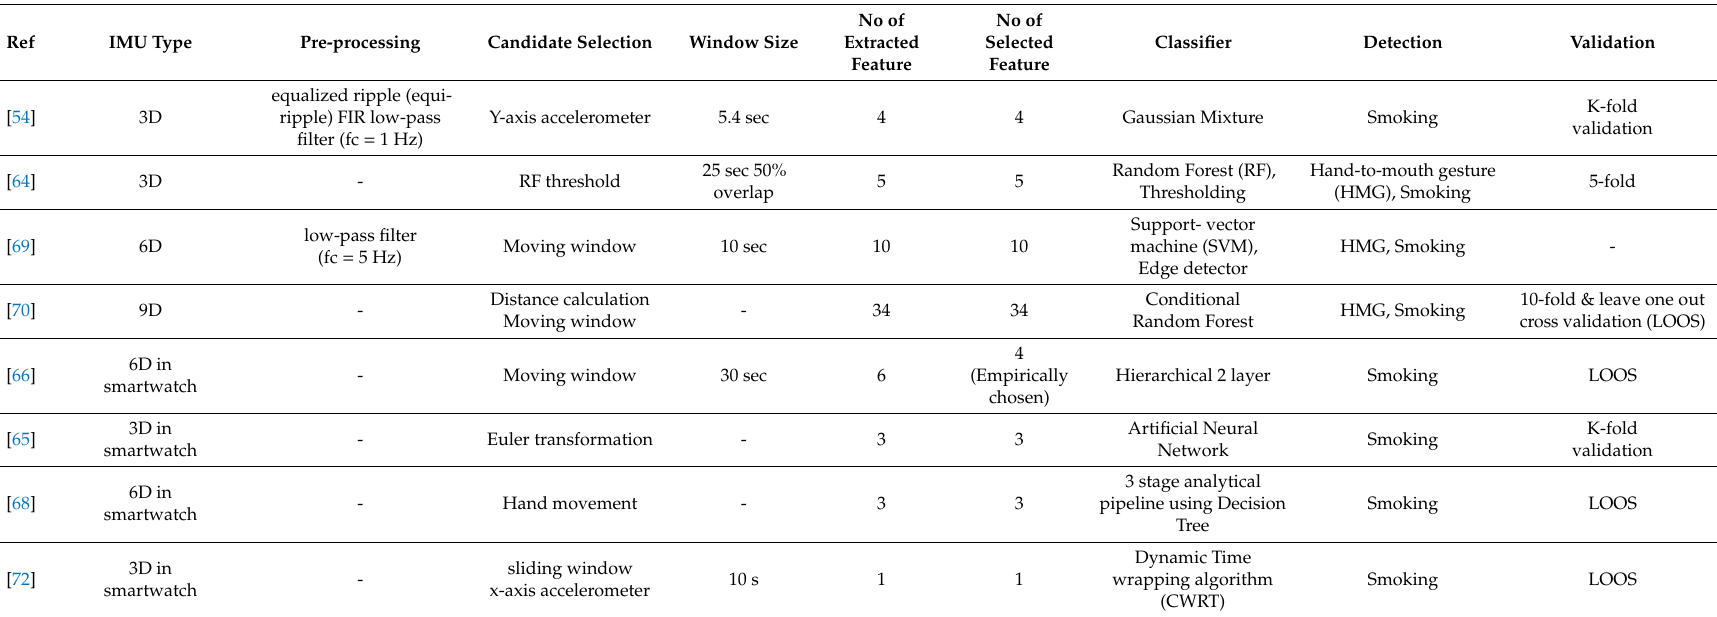
Table 7. Signal Processing and Pattern recognition techniques applied to the Inertial Measurement Unit